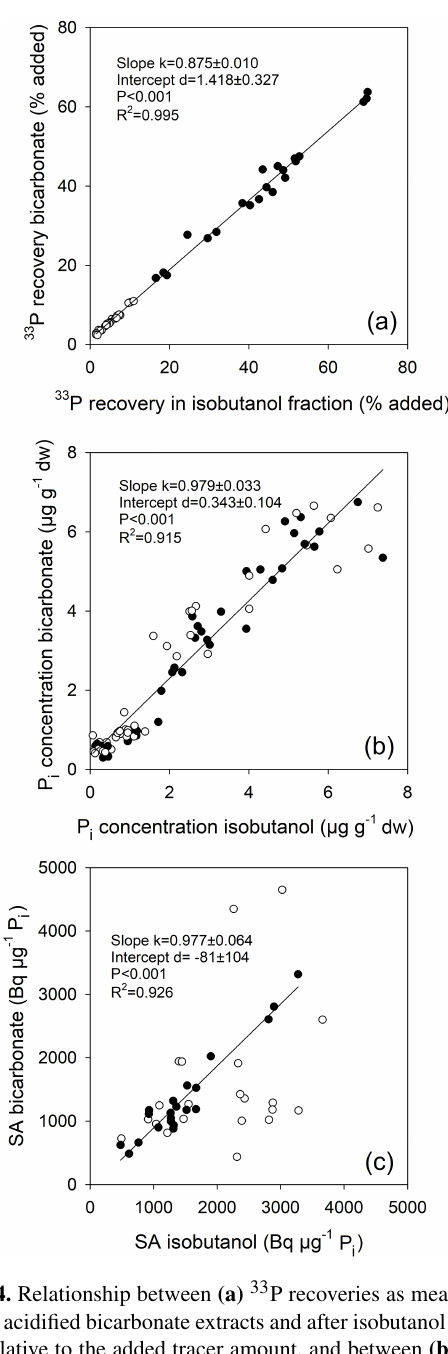
Figure 4. Relationship between (a) 33 P recoveries as measured di- rectly in acidified bicarbonate extracts and after isobutanol fraction- ation, relative to the added tracer amount, and between (b) P i con- centrations measured using the malachite green method in acidified bicarbonate extracts and after isobutanol fractionation following the phosphomolybdate blue approach. (c) Comparison of specific ac- tivities (SA) of P i measured in acidified bicarbonate extracts and after isobutanol fractionation. Regression in (c) is only for temper- ate grassland soils (closed circles); for tropical forest soils (open circles), P i concentrations were close to the detection limit of the phosphomolybdate method, impairing calculations of SA for isobu- tanol fractionation. Linear regressions are given (slopes and inter- cepts ±